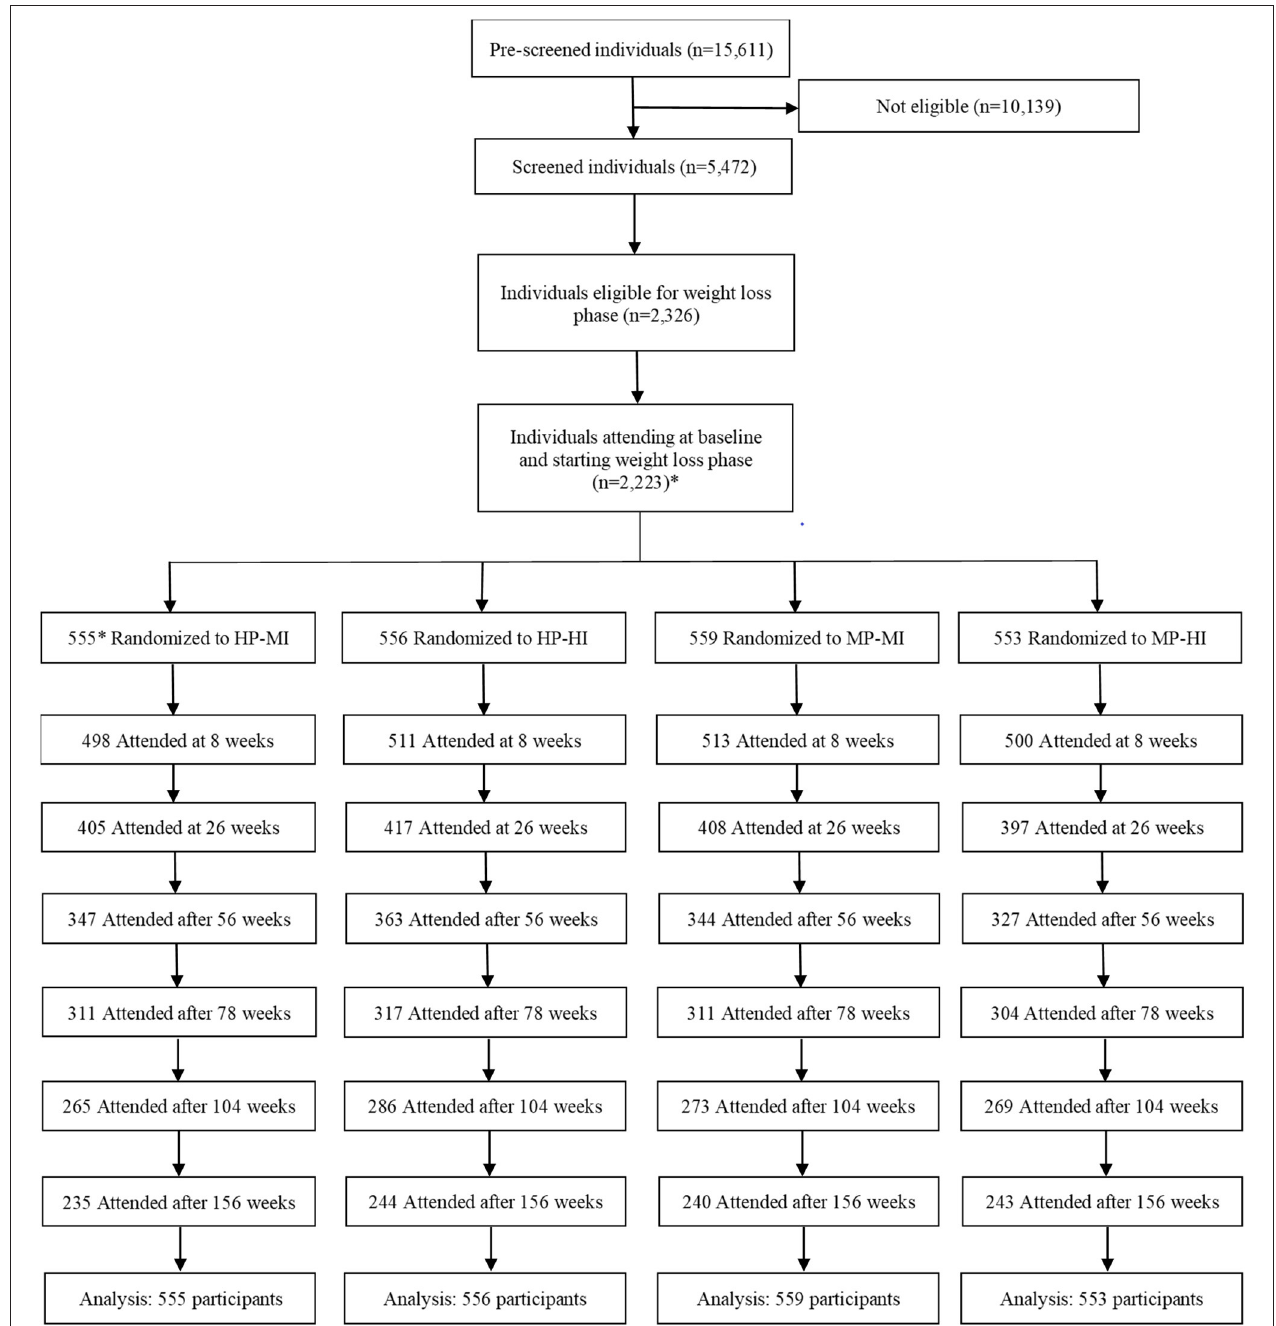
FIGURE 1 | Trial flow diagram. *A total of 2,224 individuals participated and 556 were randomized to the HP-MI group, but one of them withdrew consent and requested data deletion. HP-MI, high protein-low glycemic index diet, moderate intensity physical activity; HP-HI, high protein-low glycemic index diet, high intensity physical activity; MP-MI, moderate protein-moderate glycemic index diet, moderate intensity physical activity; MP-HI, moderate protein-moderate glycemic index diet, high intensity physical activity.